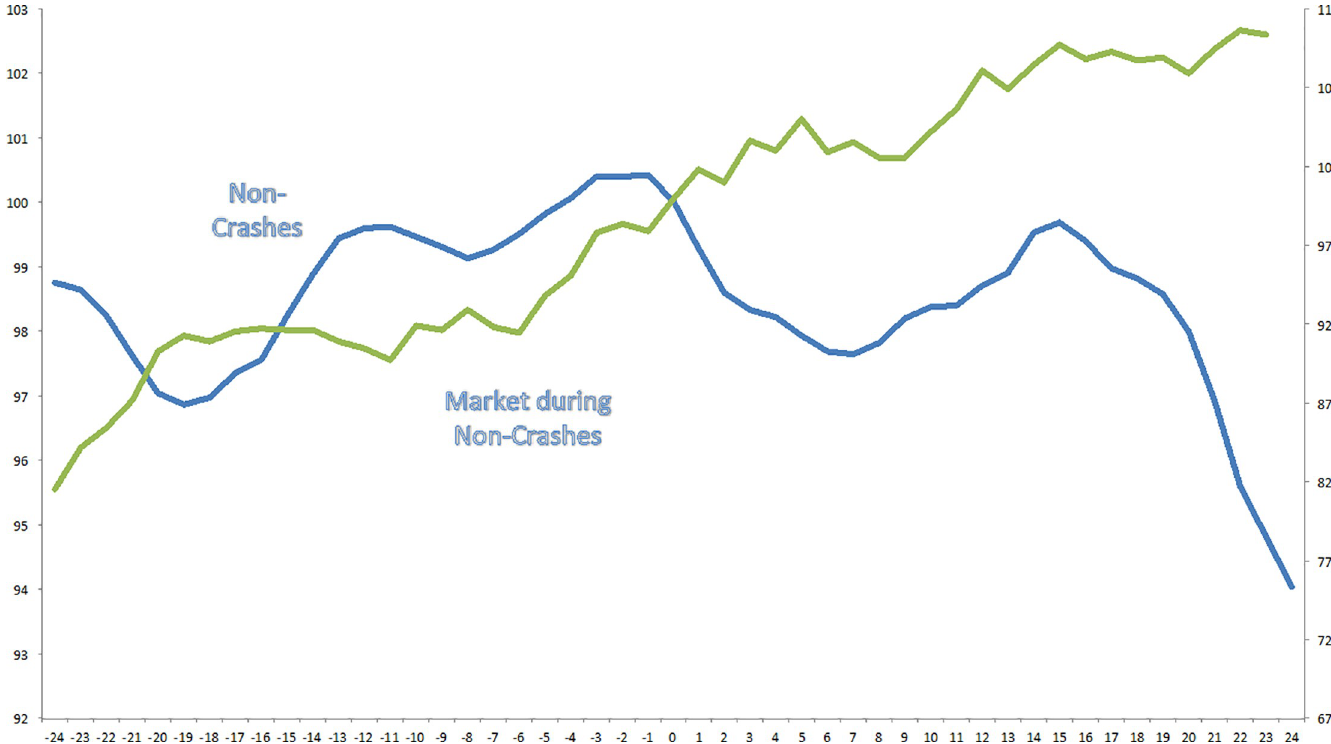
Fig 3. Fear and Euphoria during non-crashes (1959–2014). The Figure plots cumulative returns to the Euphoria Index EIx (left axis) and the S&P500 (right axis) during periods when US industries experience a large price run-up and do not crash afterwards. The sample includes all industries between 1959 and 2012 and is based on Fama and French [39] 49-industry classifications. 30 episodes are identified in which an industry experiences both a raw and net-of-market return of 100% in a two- year period, and a raw return of 50% or more in a five-year period. 15 of these 30 episodes experienced a subsequent crash, and 15 episodes did not. A crash is defined as a 40% drawdown from any point in the two years after the initial price run-up. In the figure’s horizontal axis, 0 denotes the period in which a price run-up was first observed. Both total return indices are normalized to have a value of 100 at this time.